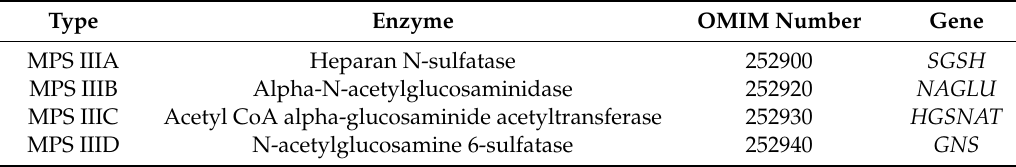
Table 3. Genes and a ff ected enzymes of MPS